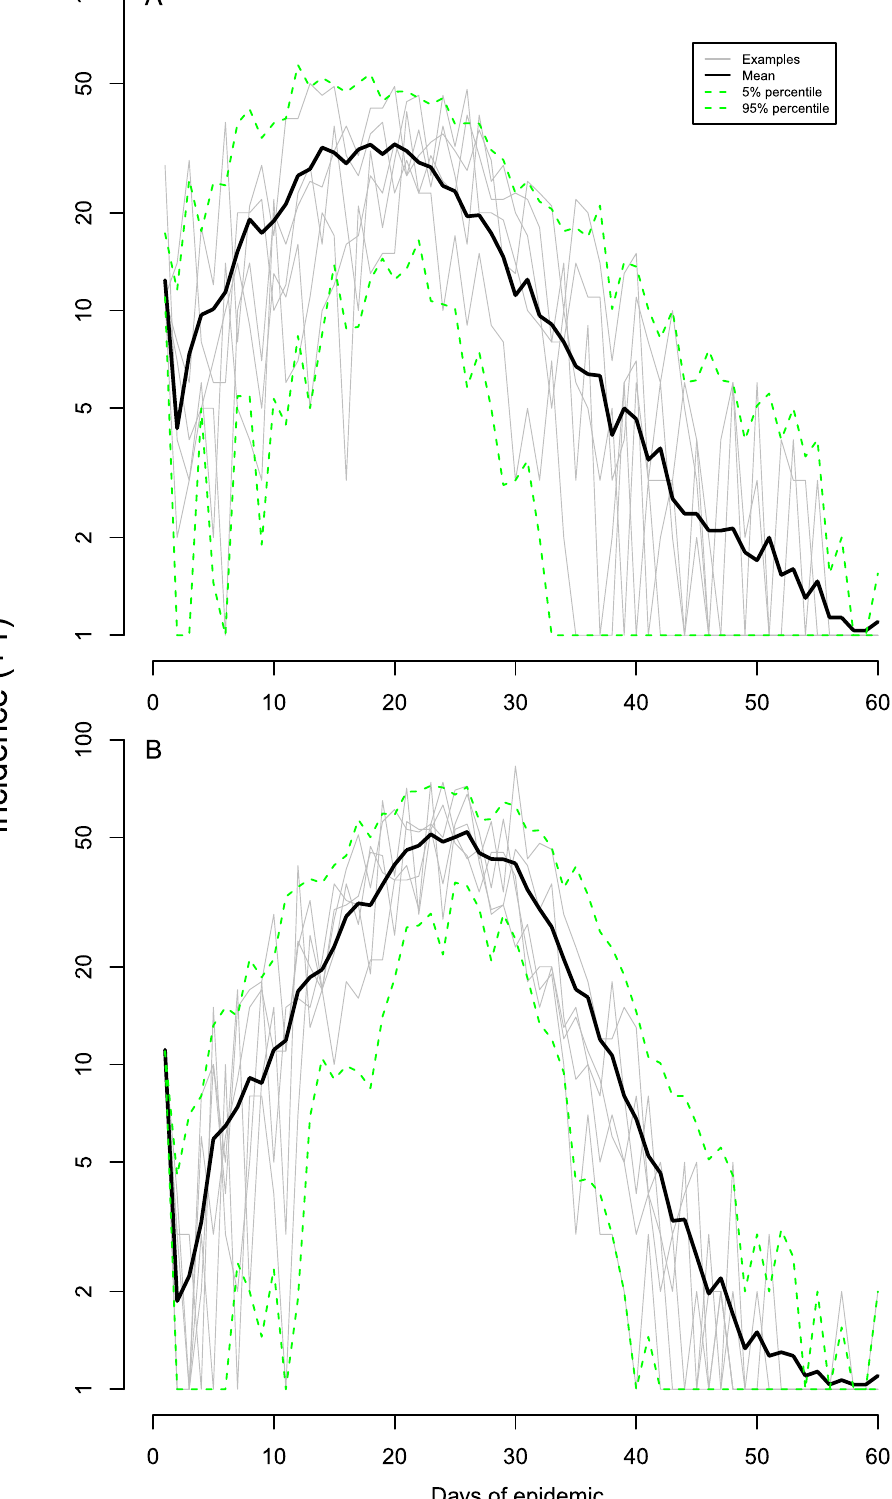
Fig 1. Simulated epidemics. Part A shows Scenario 1 with R 0 = 1.8, T g = 2.5. Part B shows Scenario 2 with R 0 = 3.0, T g = 6.25. Offspring and the serial interval assumed to follow Poisson distribution. In both scenarios, 1,000 individuals were initially susceptible and 10 people were infectious on day 1. Grey lines trace 5 single example realisations. Black lines show average case incidence, and the green dotted lines are the 5% and 95% prediction intervals from 30 realisations.